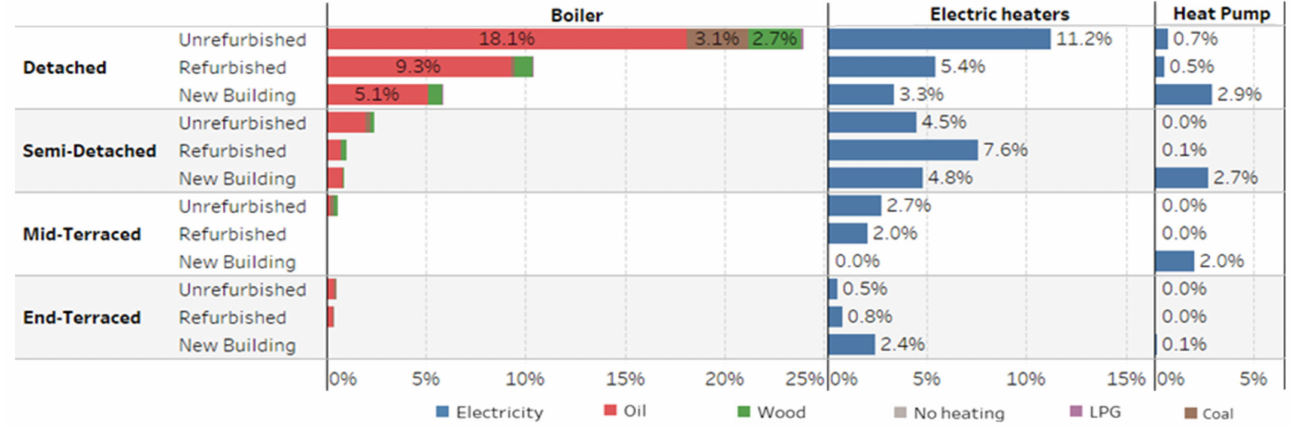
Figure 5. Proportion of main heating fuel type and the total number of